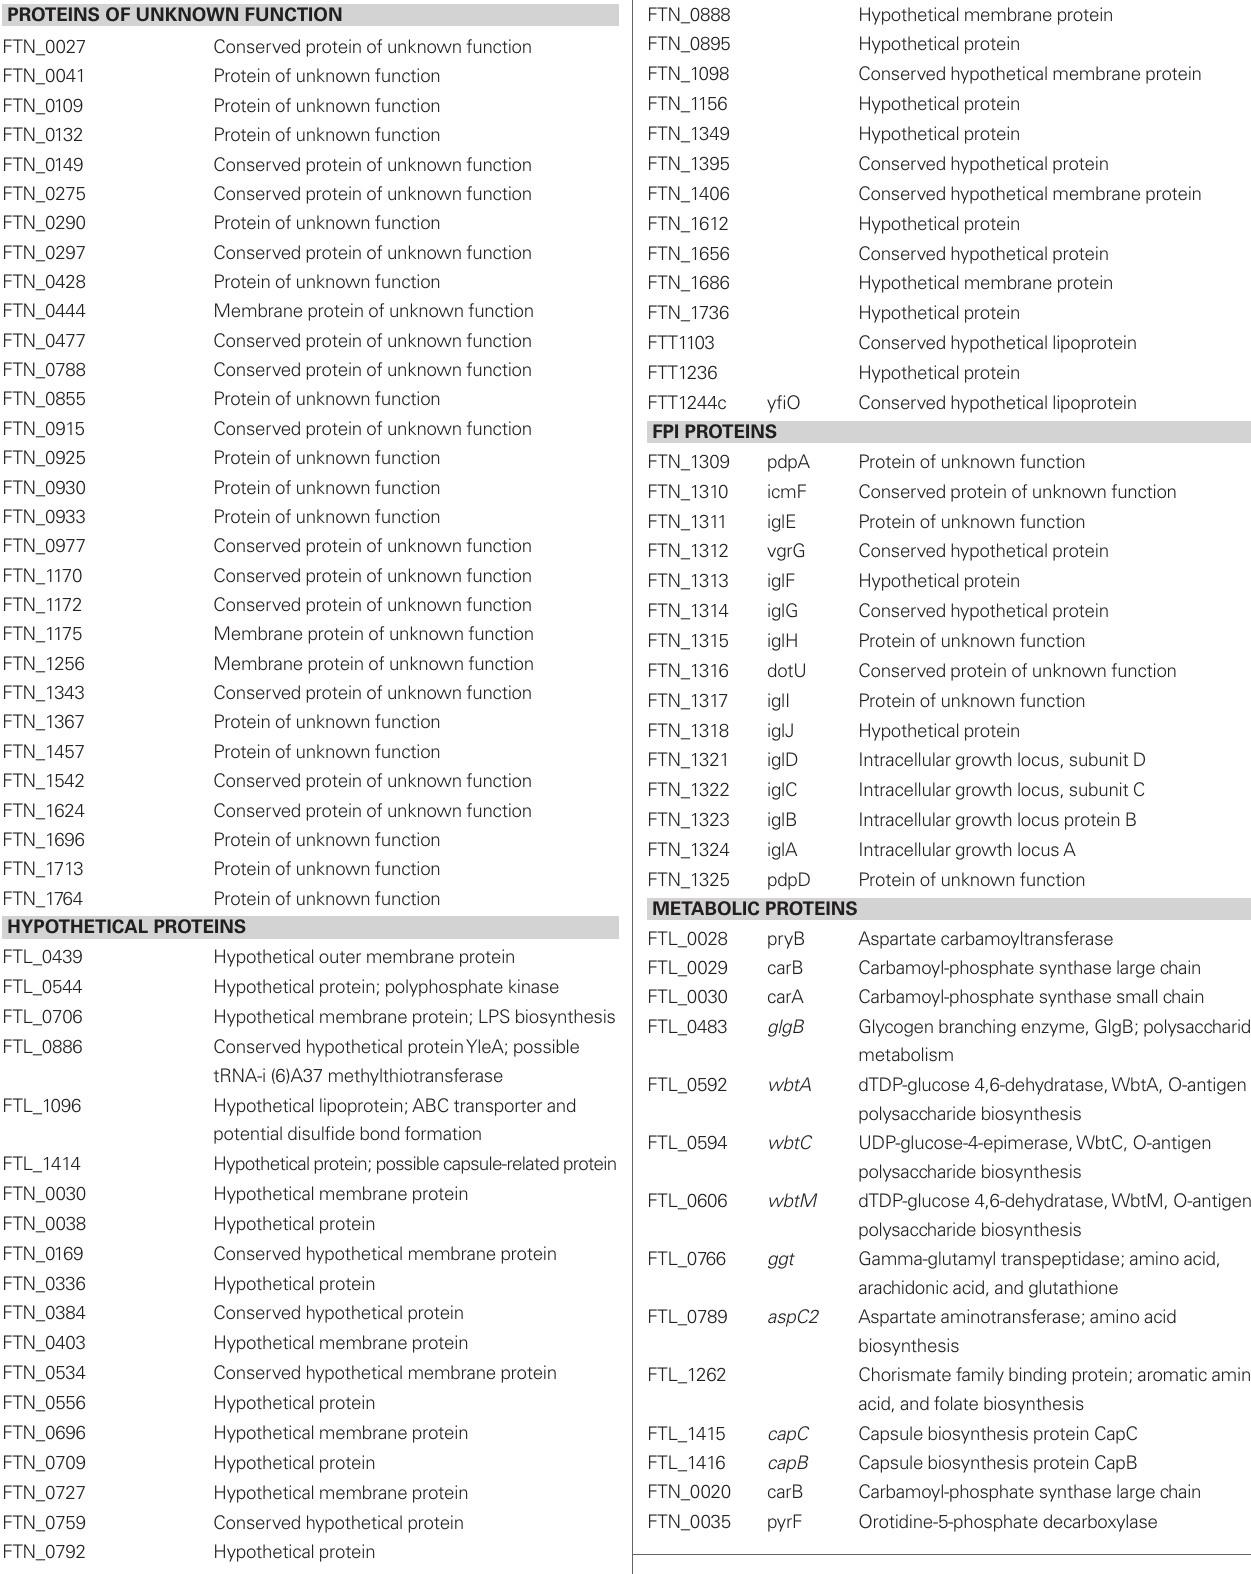
table 1 | list of intracellular growth defective